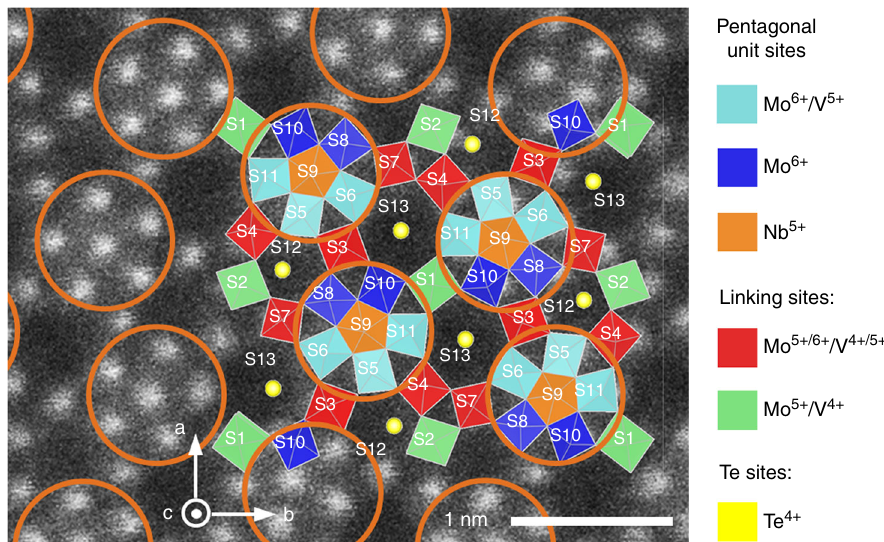
Fig. 1 Schematic view of M1 crystal in the [001] direction. Overlay of 2 × 2 unit cells representation with a high-angle annular dark- fi eld scanning transmission electron microscopy (HAADF-STEM) image of M1 basal plane. Different colors of crystallographic sites indicate occupancy by different metals and oxidation states. To guide the eye, pentagonal Nb-centered M 6 O 21 building blocks have been marked with orange